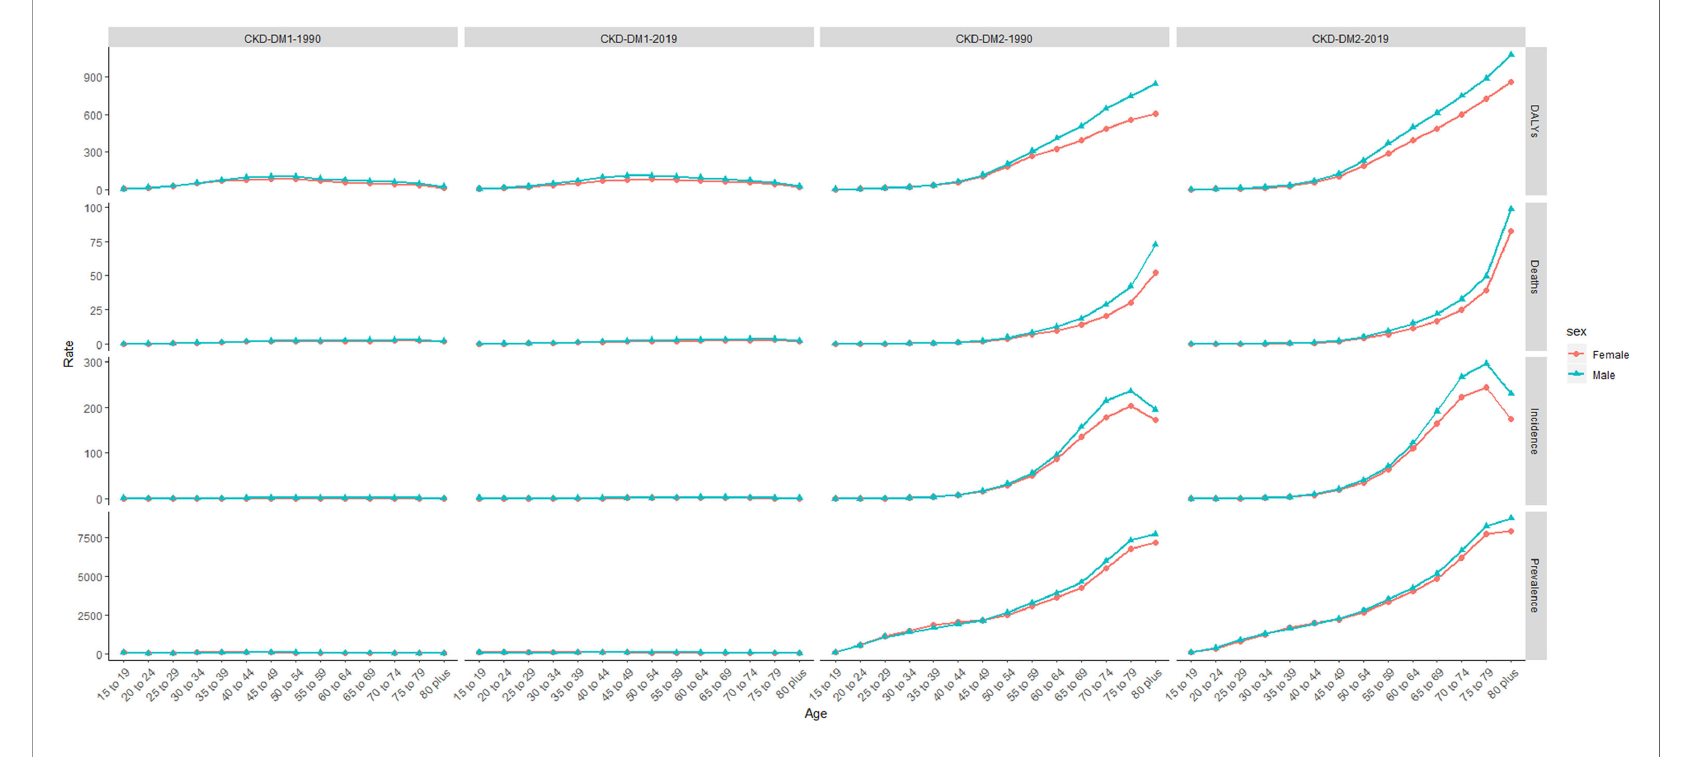
FIGURE 1 | The incidence, prevalence, death, and DALY rate of CKD-DM burden from 1990 to 2019. CKD-DM1-1990 represents the incidence, prevalence, death, and DALY rate of type 1 diabetes – related CKD in 1990. CKD-DM1-2019 represents the incidence, prevalence, death, and DALY rate of type 1 diabetes – related CKD in 2019. CKD-DM2-1990 represents the incidence, prevalence, death, and DALY rate of type 2 diabetes – related CKD in 1990. CKD-DM2-2019 represents the incidence, prevalence, death, and DALY rate of type 2 diabetes-related CKD in 2019. CKD-DM, chronic kidney disease caused by diabetes; DALY, disability adjusted life-year. The vertical axis is the incidence, prevalence, death, and DALY rate (per 100,000 people), and the horizontal axis is the different age-groups